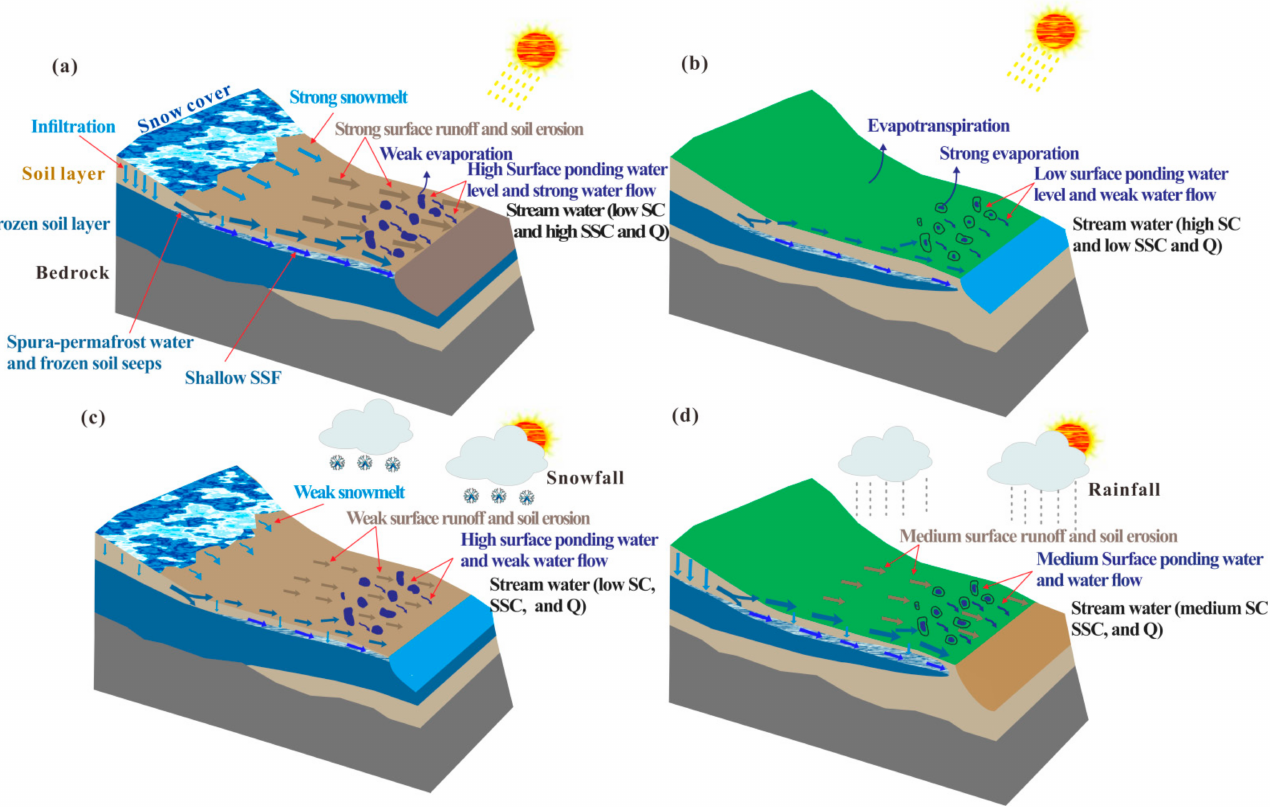
Figure 7. Schematic figures illustrating the generation and transport processes of runoff (Q), sus- pended sediment (SSC), and solute (SC) of the Binggou catchment during the spring period (left panels) and the summer period (right panels) under heavy snowmelt events ( a ), dry conditions ( b ), heavy snowfall events ( c ), and heavy rainfall events ( d ). Note that the conceptual diagrams partly refer to the conceptual diagram shown in [46,65], and arrow sizes approximate the magnitudes of the water